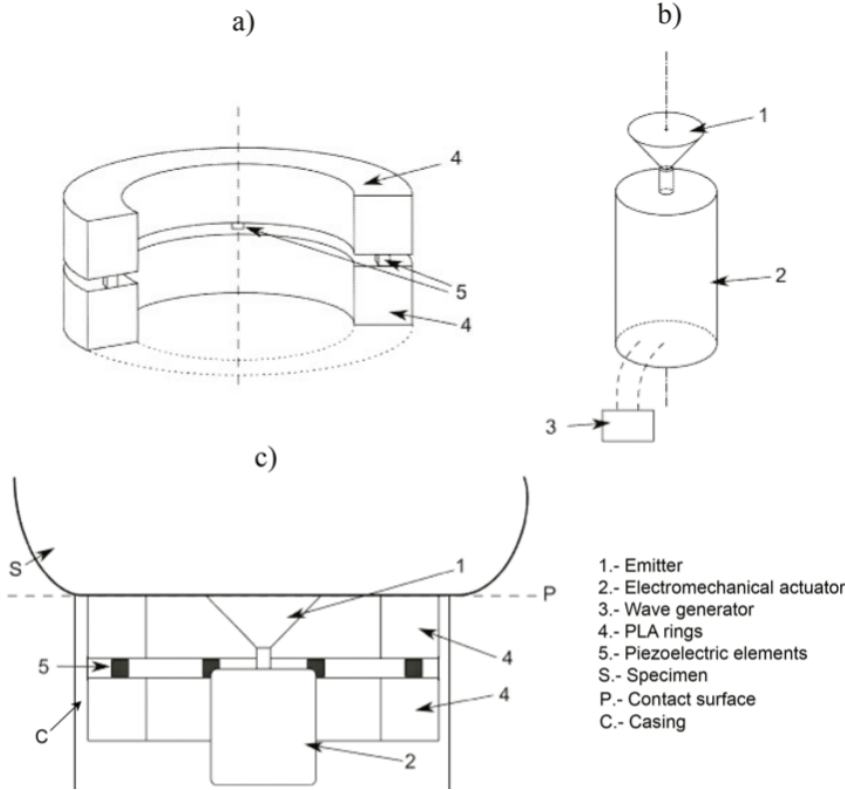
Figure 1. Schematic view of the sensor elements. ( a ) the receiver; ( b ) the emitter; ( c ) contact